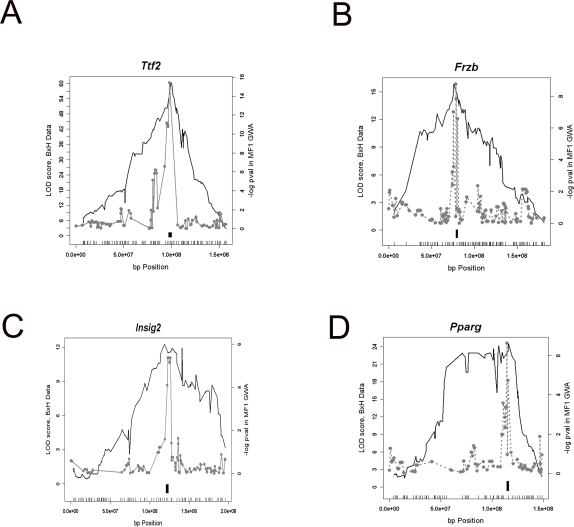
Comparison of four conserved local eQTL mapping results between the MF1 and BxH studies.In each plot, the black curve depicts the LOD curve in the BxH data, and the gray curve is the association result in the MF1 data. The physical location of the gene is shown by the black box. In each panel, the tick marks on x-axis depicts the physical location of the markers used in the BxH study. A) Ttf2, B) Frzb, C) Insig2, D) Pparg.